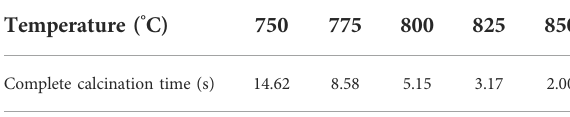
TABLE 5 Calcination time for coal gangue, as calculated using the reaction kinetic